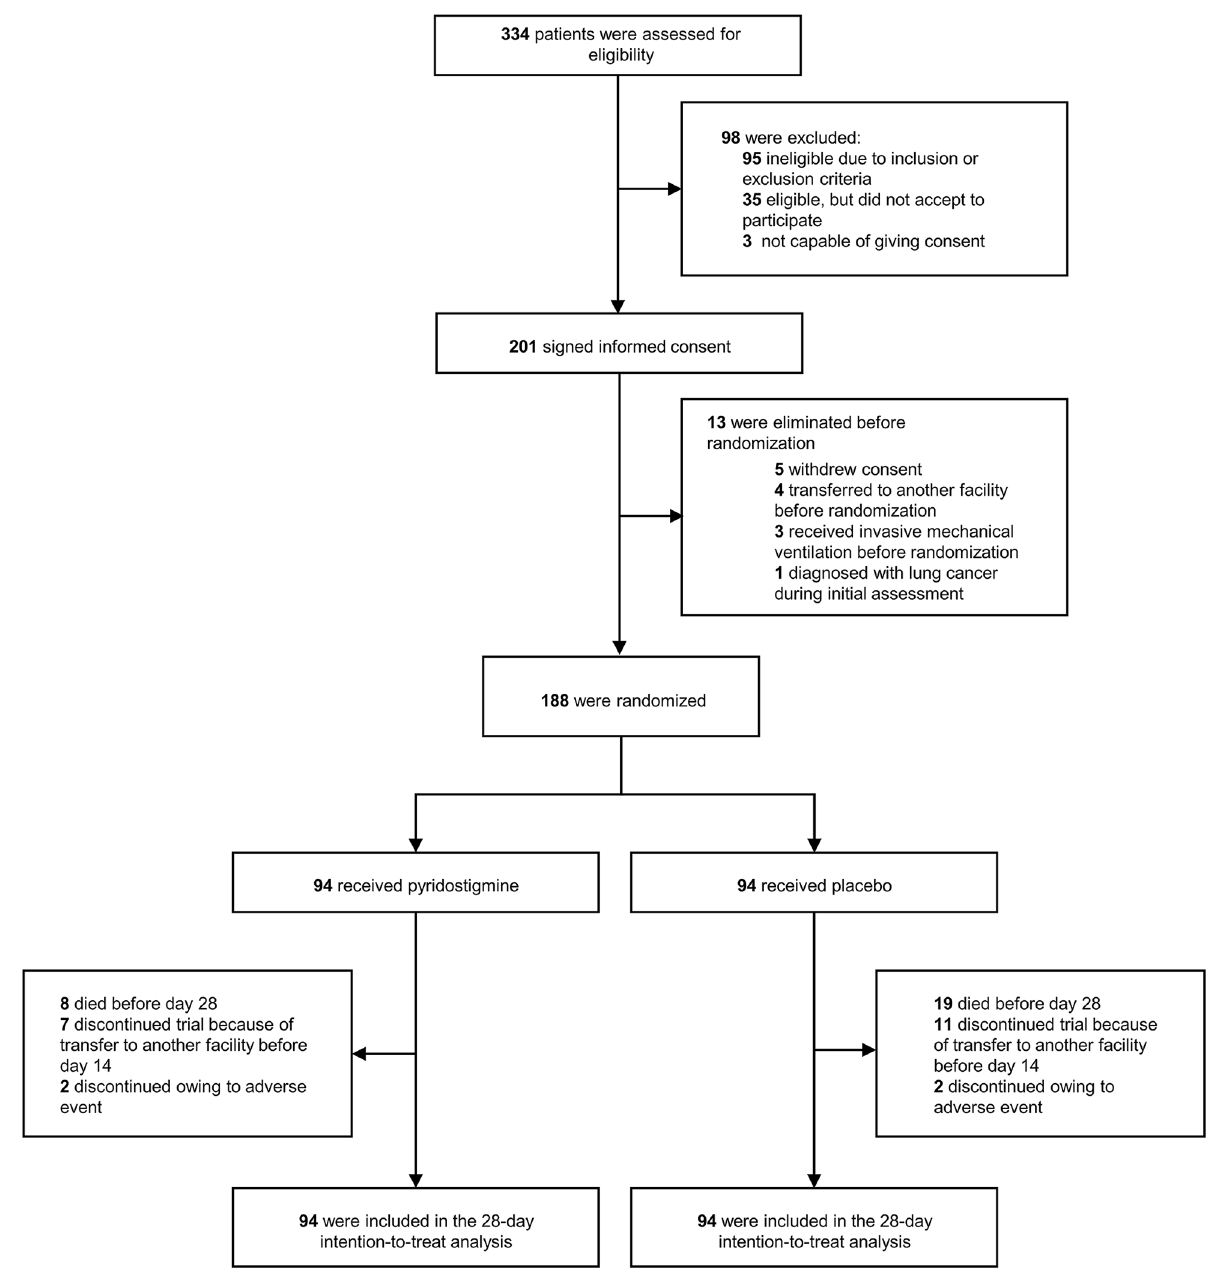
Fig. 1 Patient selection